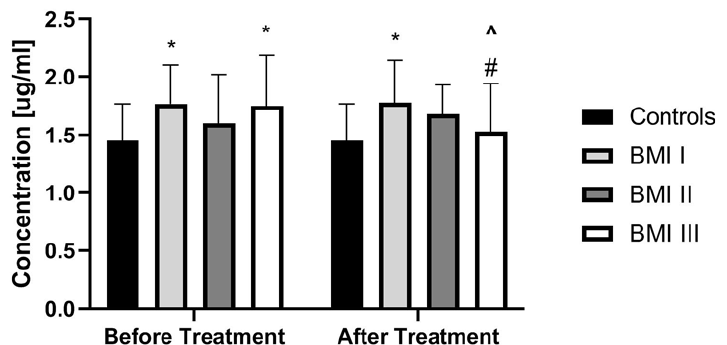
Figure 3. Comparison of PCSK9 concentrations between controls and patients sub-groups divided on a base of BMI scoring before and after treatment. * means statistical significance with p < 0.05 compared to Controls. # means significance with p < 0.05 compared to BMI 1 and BMI 2 subgroups. ^ means statistical significance with p < 0.05 for BMI 3 before treatment vs the same group after treatment. BMI, body mass index.